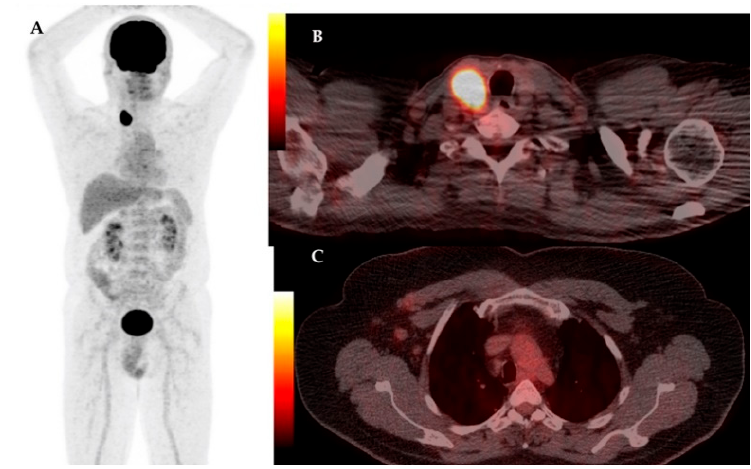
Figure 5. Male patient with right breast cancer, with right axillary lymphnodes suggestive for metastases. Synchronous confirmed papillary thyroid carcinoma of the right lobe. MIP image on F18-FDG PET/CT ( A ); axial section at cervical level showing thyroid right lobe lesion with increased F18-FDG uptake confirmed thyroid carcinoma on total thyroidectomy ( B ); axial section at thorax level showing pathologic slightly increased F18-FDG uptake in right axilla in the lymphnodes,